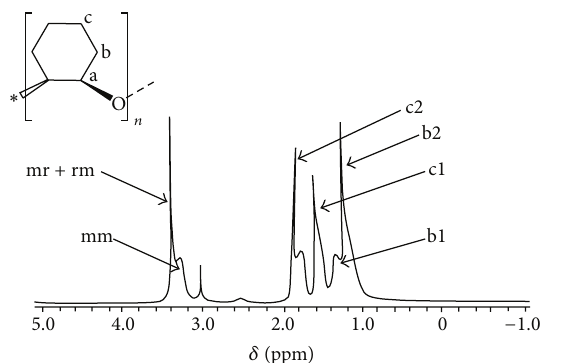
Figure 3: 1 HNMR spectrum of PCHO. Polymerization catalyzed by